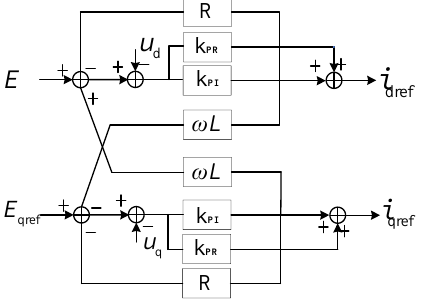
Figure 8. Improved stator electrical equation.